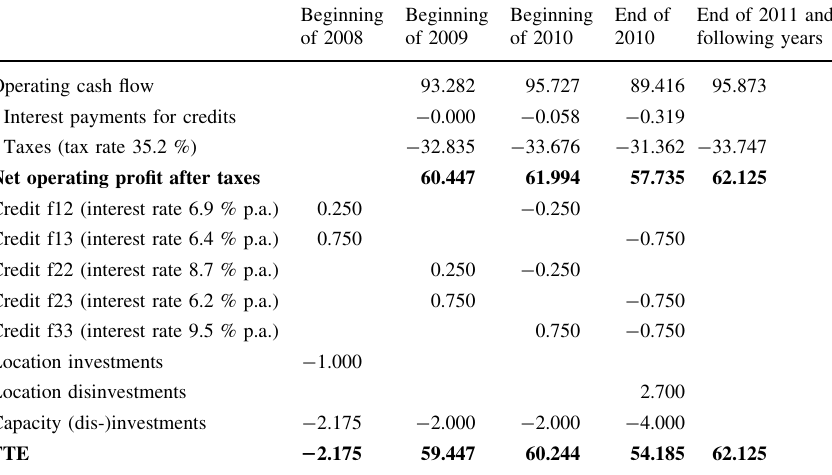
Table 1 Calculation of FTE (in EUR